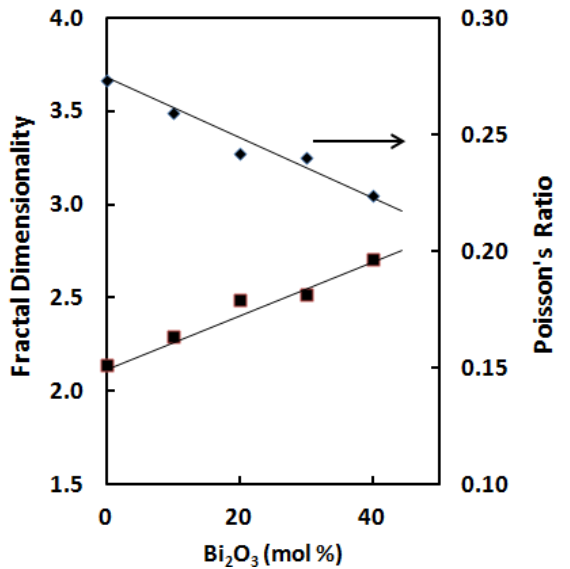
Figure 5. Variation of fractal dimensionality and Poisson’s ratio of